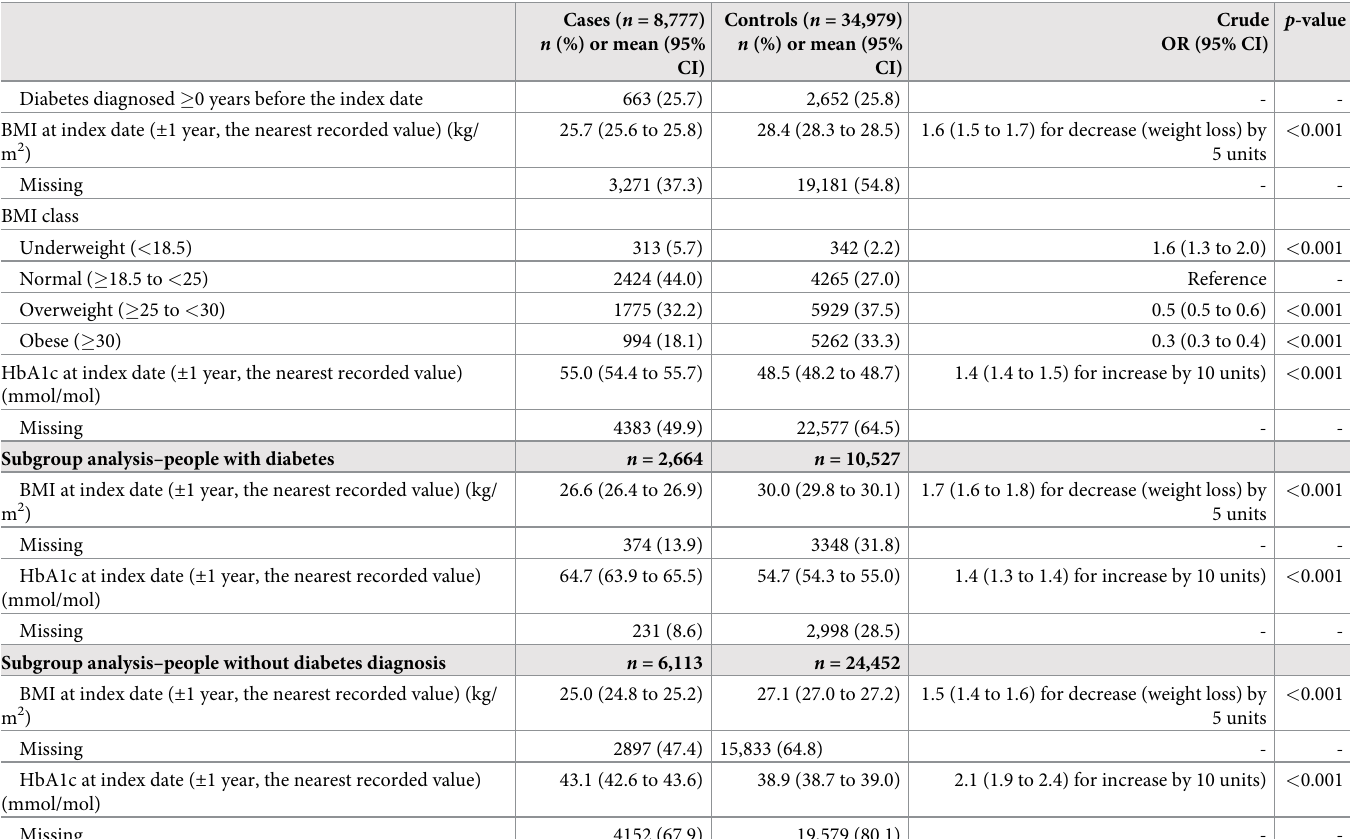
time they were diagnosed with pancreatic cancer, cases with diabetes lost more weight on aver- age than cases without diabetes (Fig 2B). This is reinforced by the subgroup analysis by diabe- tes presented in Table 1. We see that at the index date, BMI of cases with diabetes was 3.4 BMI units lower than their matched controls (26.6 [95% CI 26.4 to 26.9] versus 30.0 [95% CI 29.8 to 30.1]). While for cases without diabetes, BMI was 2.1 units lower than that of their matched who weighed 5 kg/m 2 less than their matched controls, were 1.7 (1.6 to 1.8, p < 0.001) times more likely to be diagnosed with pancreatic cancer, while cases without diabetes who weighed 5 kg/m 2 less than their matched controls, were 1.5 (1.4 to 1.6, p < 0.001) times more likely to be diagnosed with pancreatic cancer. This constitutes a 20% difference in pancreatic cancer risk between people with and without diabetes, if they lose weight. For comparison, there was no difference in weight loss trends between genders and the modelled BMI trends and their 95% CIs presented in Fig 2C overlap. A similar trend in longitudinal plots was observed for HbA1c as was seen with BMI (Fig 2). Although HbA1c increased before the diagnosis of pancreatic cancer for both subgroups, the change started about 2 years earlier (-3 years versus -1 year) and was larger for cases with dia- betes as compared to cases without diabetes. The difference in HbA1c at the index date between cases and controls with diabetes was 10 mmol/mol and between cases and